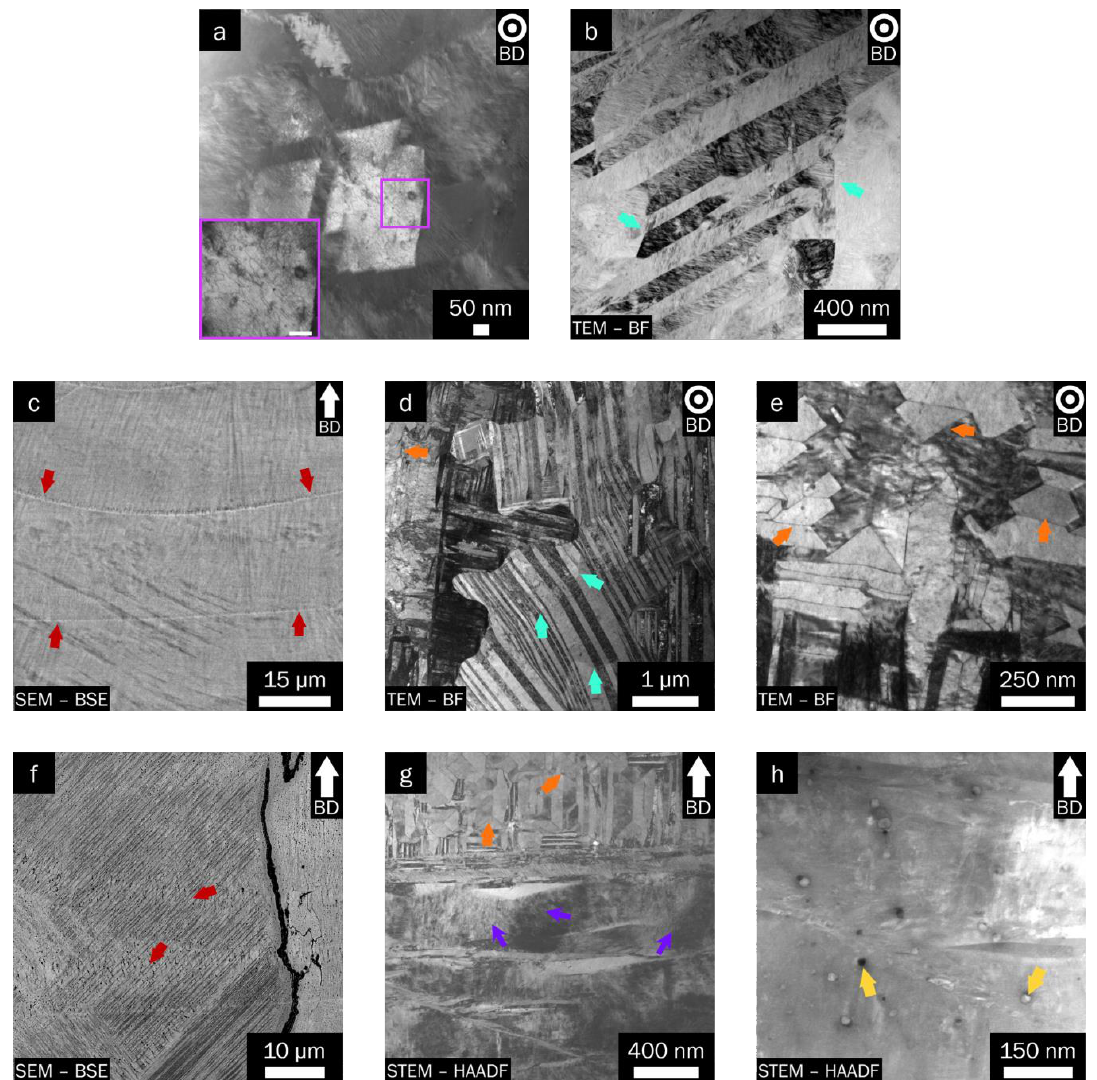
Figure 4. SEM and S / TEM micrographs of samples ( a , b ) A2, ( c – e ) A8, and ( f – h ) A10; BD indicates building direction. Aqua, red, yellow, and orange arrows show martensite laths, melt-pool boundaries, and dark and light secondary phases, respectively.